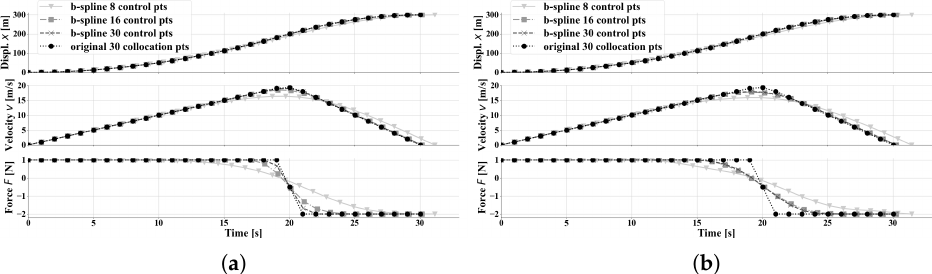
Figure 11. Bangbang solution using different approaches. ( a ) Control using b-spline. ( b ) Control and states using